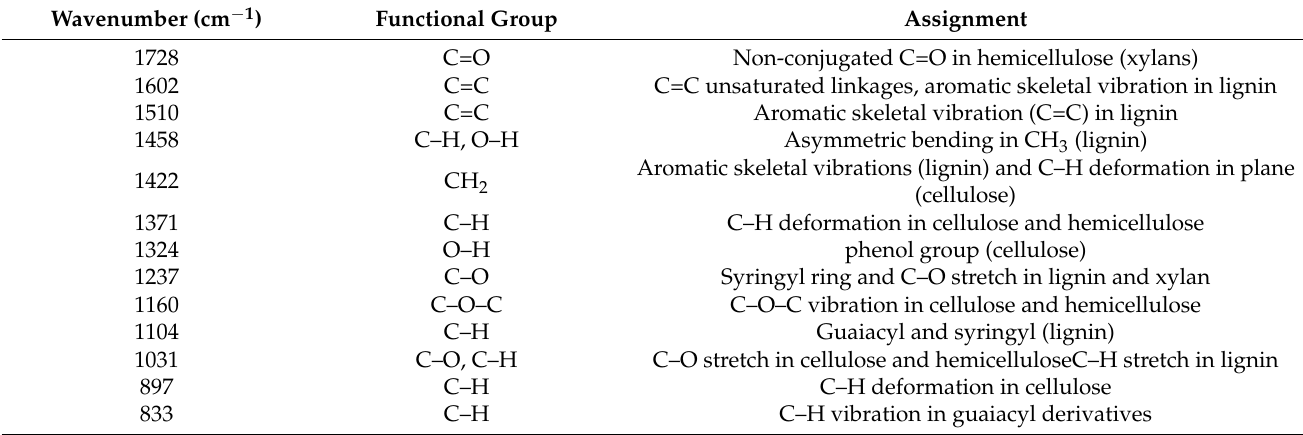
Table 1. Assignment of FTIR spectra absorption peaks of natural bamboo